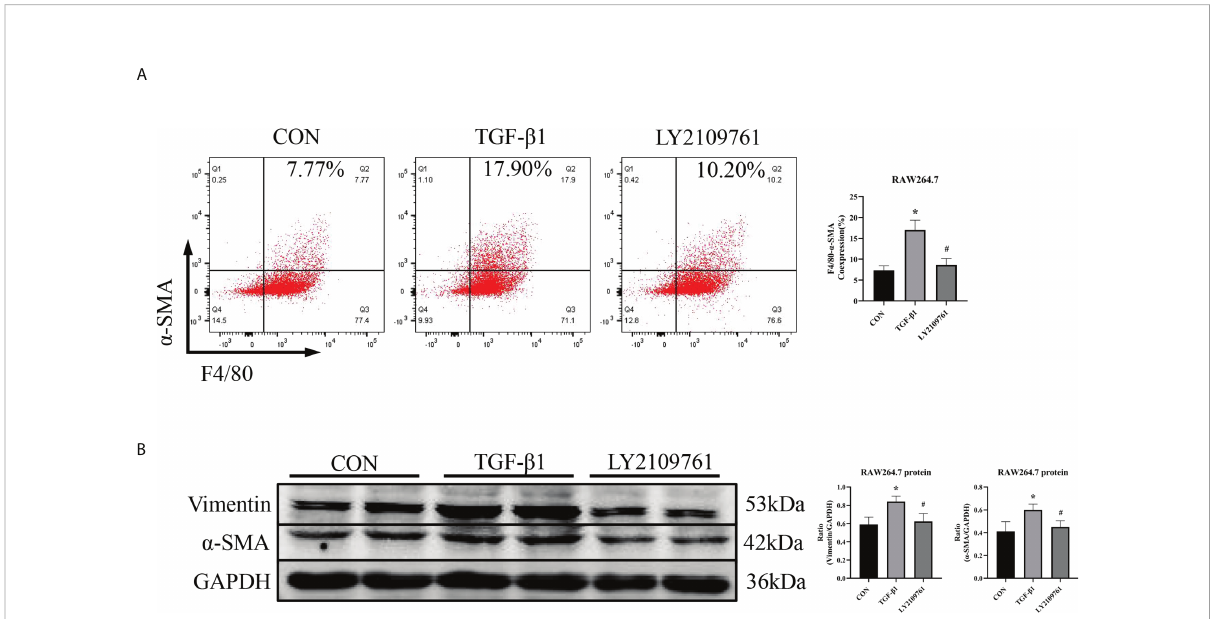
FIGURE 7 The TGF- b 1 receptor blocker LY2109761 antagonized MMT in TGF- b 1-treated RAW264.7 cells. (A) Flow cytometric analysis of the expression of a -SMA in RAW264.7 cells, and Q2 indicates the percentage of MMT cells (n = 3). (B) Western blotting analysis of a -SMA and vimentin expression in RAW264.7 cells stimulated with TGF- b 1 and treated with or without LY2109761 (n = 6). The data are presented as the mean ± SD, *p < 0.05 vs. CON, # p < 0.05 vs. TGF- b 1. MMT, macrophage-to-myo fi broblast transition.